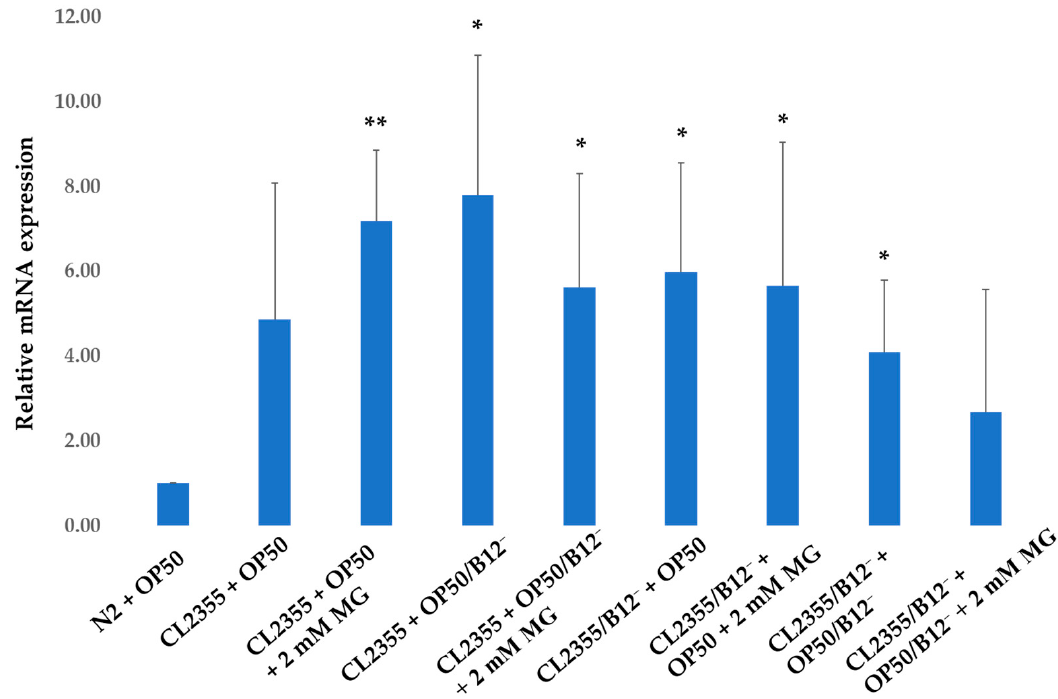
Figure 8. Expression of lrp-1 gene on CL2355 and CL2355/B12 − worms fed with either OP50 or OP50/B12 − with or without 2 mM mogrosides (MG). The fold-change (2 − ∆∆ Ct ) and standard deviations of the gene expression were calculated from three independent experiments. All treatments were compared to N2 + OP50. The Student t -test was conducted to assess the statistical significance (* p < 0.05; ** p < 0.01).